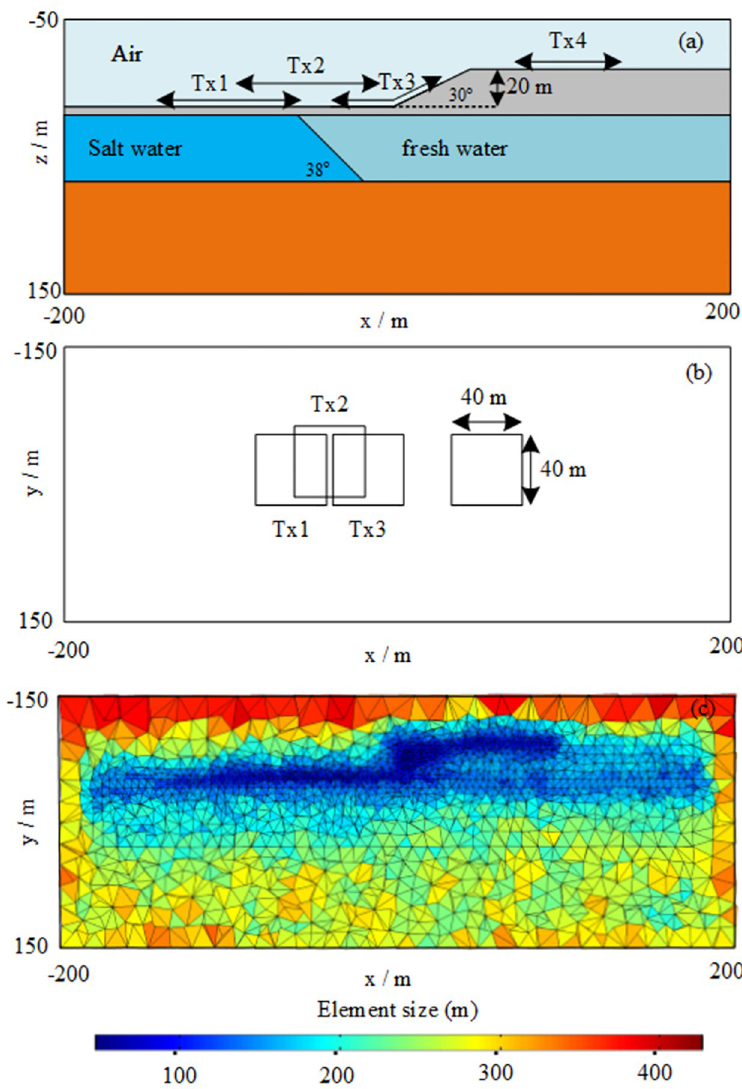
Fig 16. (A) Geometric diagram of the cross-section of the undulating terrain model. (B) Horizontal projection position of loops (i.e., Tx1–Tx4). (C) The unstructured meshes for the model.